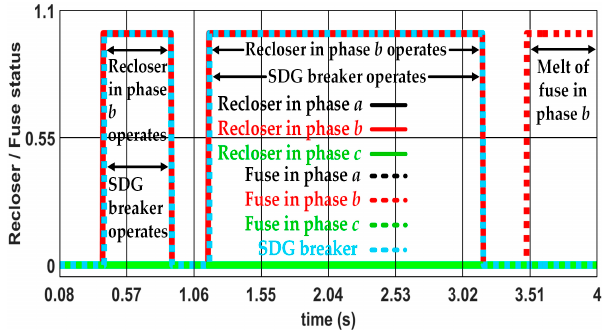
Figure 16. Operating time of recloser–fuse and SDG breaker under separated phase–current controls during permanent SLG fault.